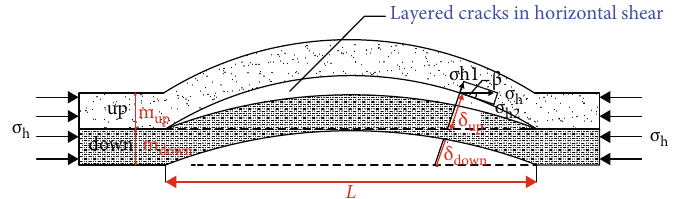
Figure 2: Sketch map of normal opening layer to fi ssure formation.